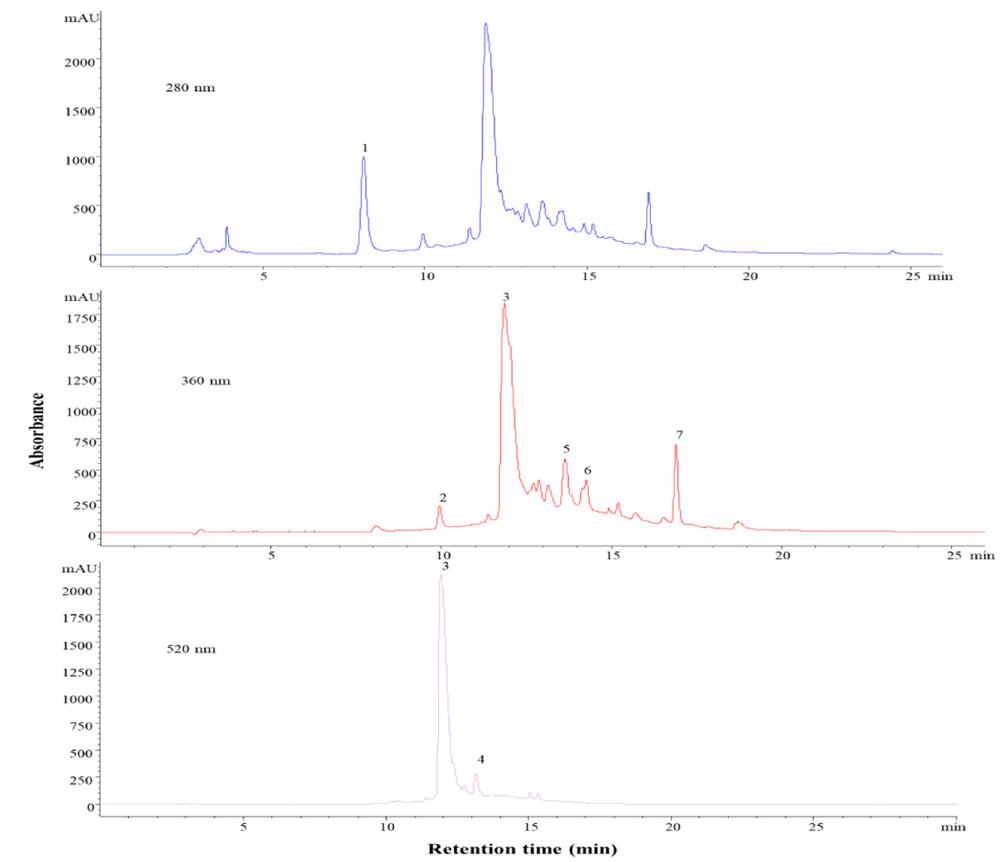
Figure 7. HPLC-PDA chromatograms of black carrot recorded at 280, 360 and 520 nm. Table 7. Characterization of phenolic compounds in black carrot via positive